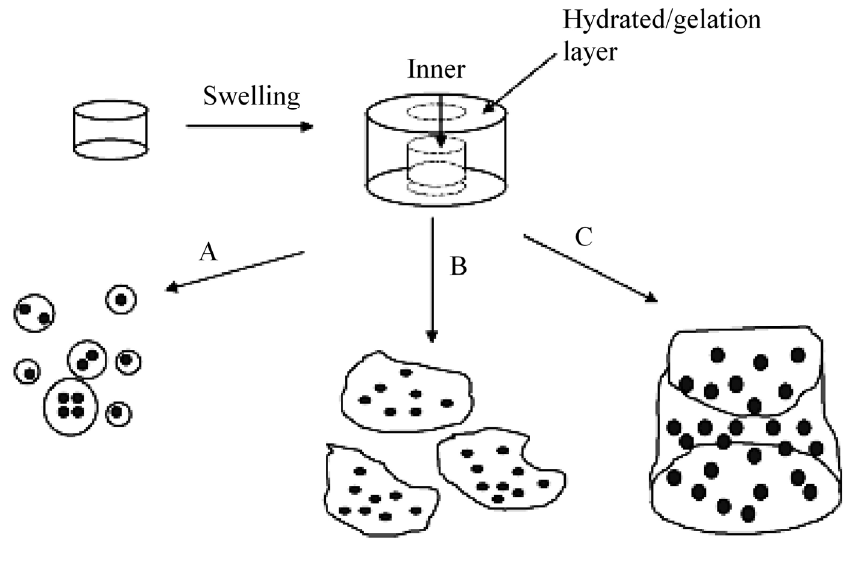
Figure 26. Water uptake process and subsequent disintegration of tablets in the drug release process (A stands for 6 mPa.s HPMC; B for 40–60 mPa.s HPMC and C for 4000 mPa.s